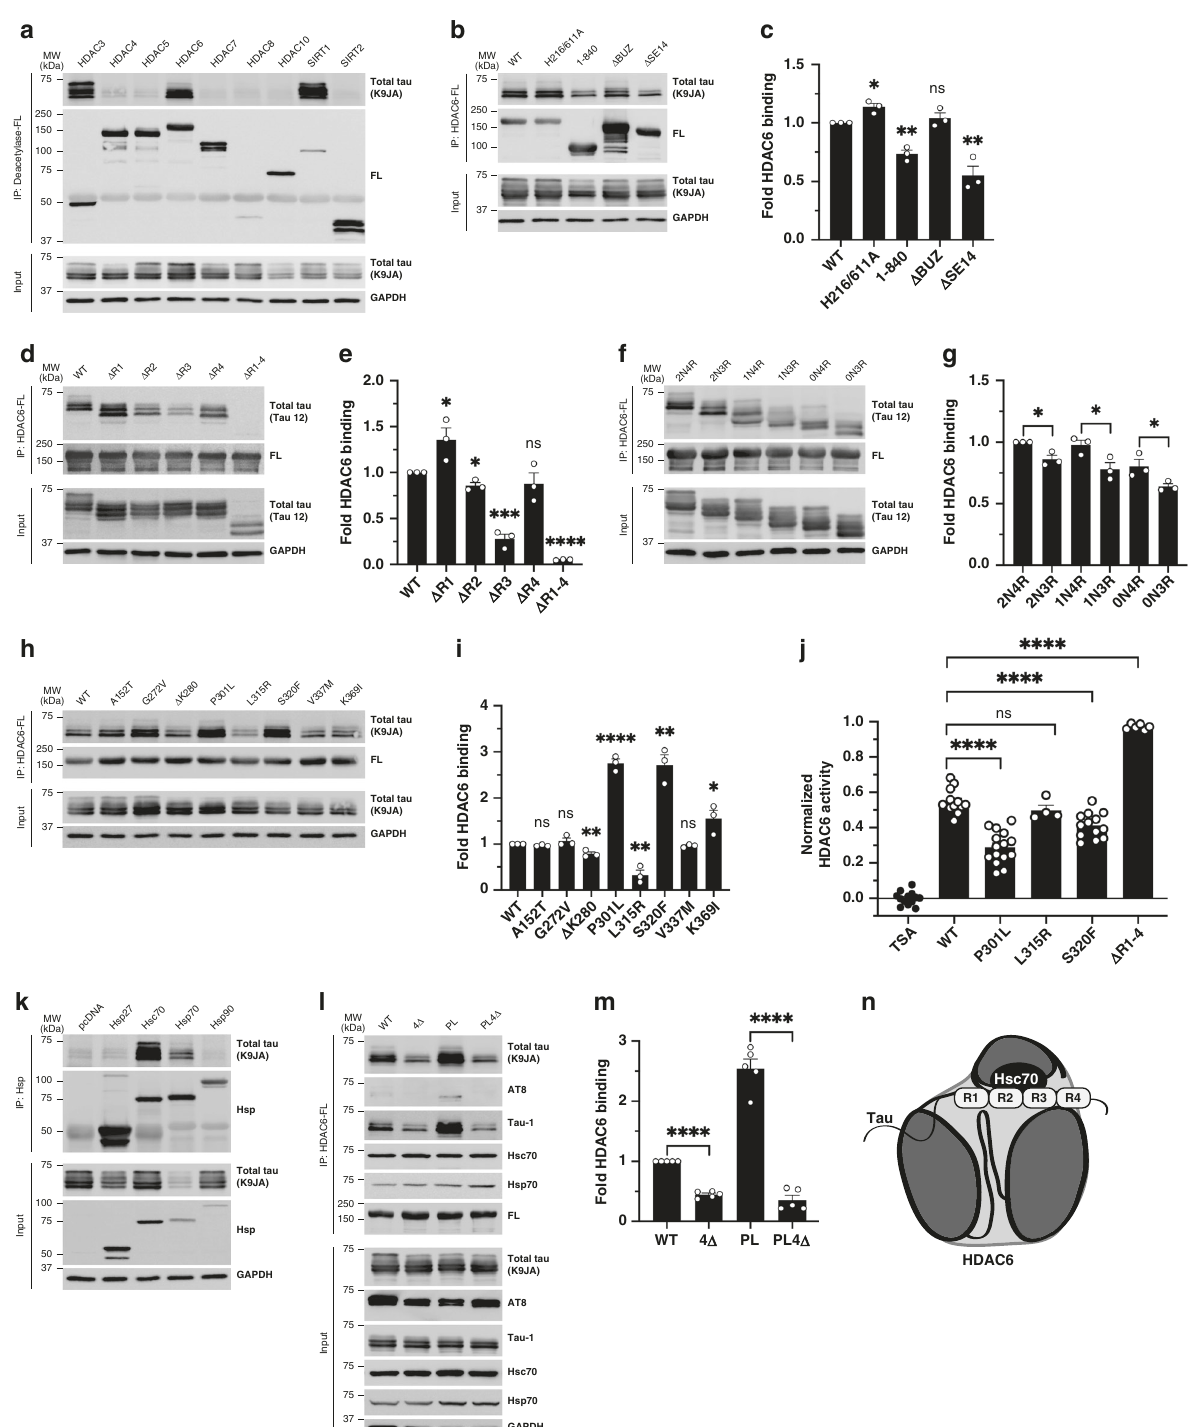
Fig. 1e). Thus, binding of the tau R2/R3 aggregate-prone motifs to HDAC6 is suf fi cient to impair HDAC6 activity, an effect that is modulated by the presence of disease-linked familial tau mutations. Heat shock proteins (Hsps) including Hsp70 family members interact with tau via the R2 and R3 motifs in the MTBR 34